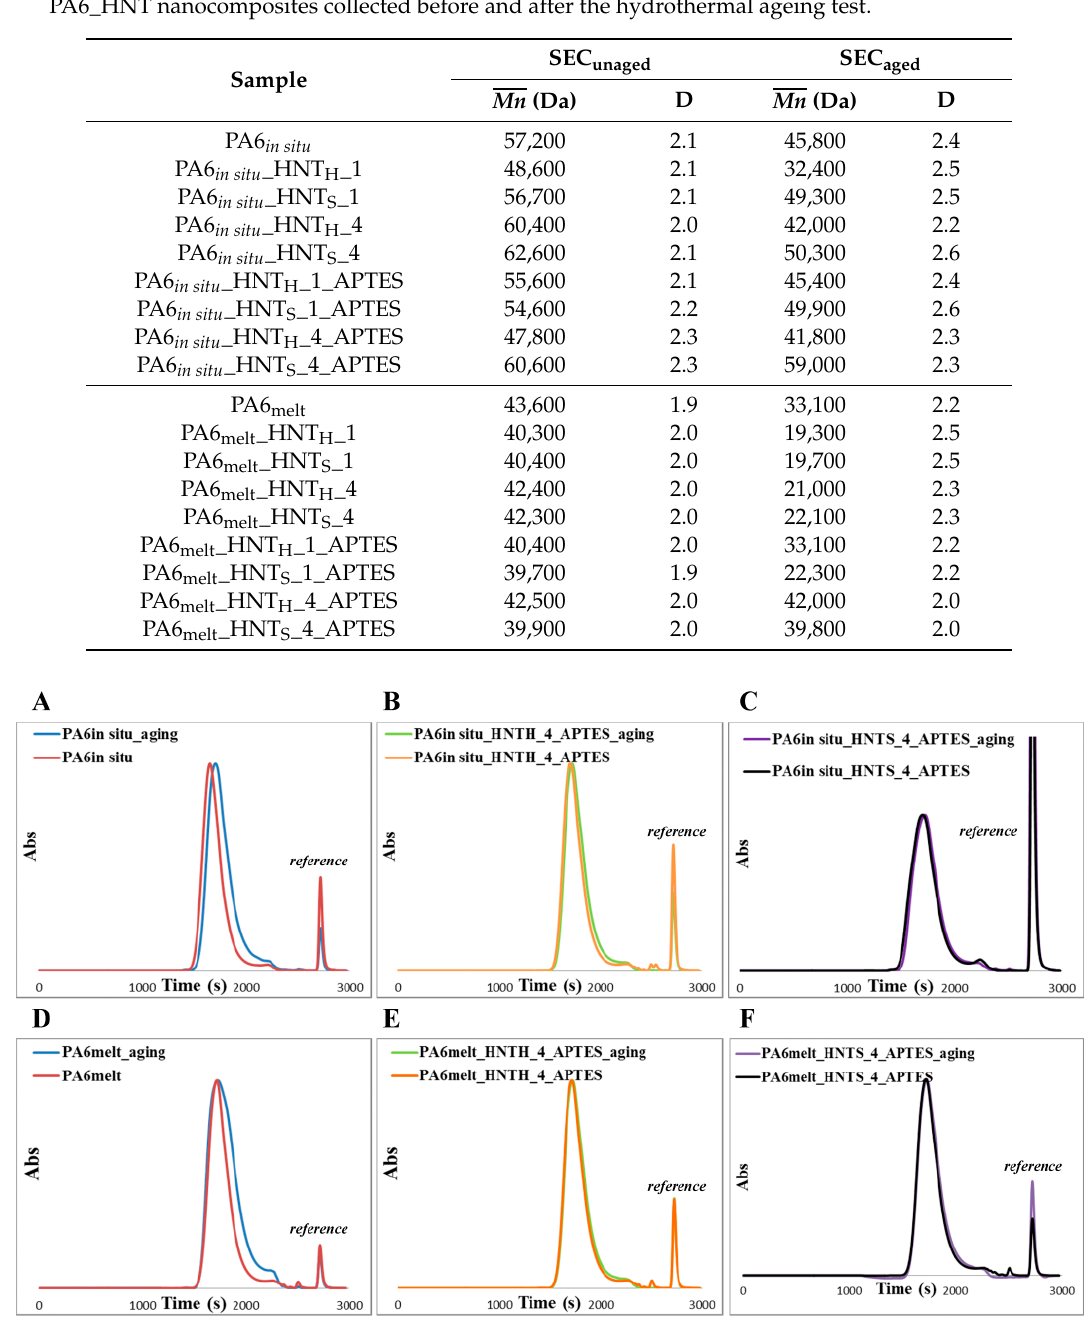
Figure 7. SEC curves before and after the ageing test of ( A ) PA6 in situ , ( B ) PA6 in situ _HNT H _4_APTES,